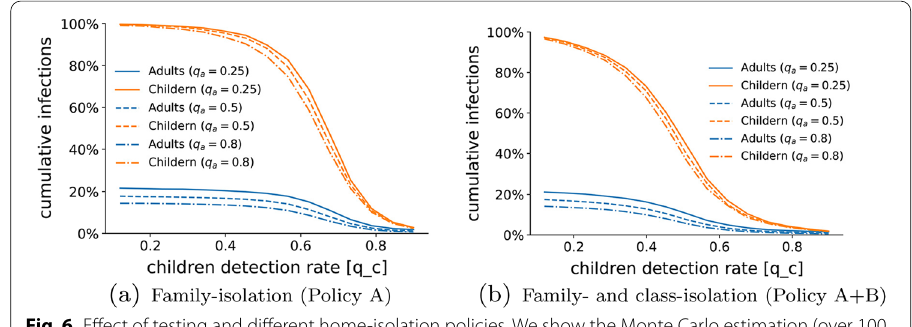
Fig. 6 Effect of testing and different home-isolation policies. We show the Monte Carlo estimation (over 100 independent simulations) of the cumulative fraction of infections among adults (blue) and children (orange) at the end of the pandemic outbreak as a function of the children detection rate q c and for three different values of adult detection rate, representative of low testing q a = 0.25 (solid), moderate testing q a = 0.5 (dashed), and massive testing q a = 0.8 (dash-dotted). In ( a ), we utilize the family-isolation policy (Policy